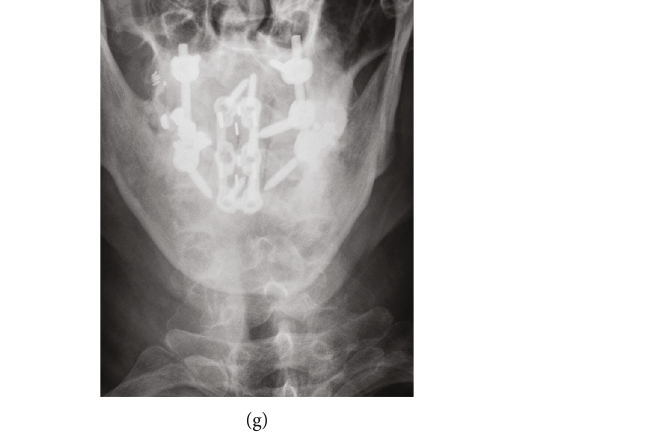
Figure 2: Case 2: aggressive osteoblastoma in C3. (a – d) CT scan reconstructions of the cervical spine with a right-sided lesion in C3. (e) MRI shows the soft-tissue component of the tumor. (f, g) Postoperative a.p. and lateral radiographs after resection of the tumor and combined posteroanterior